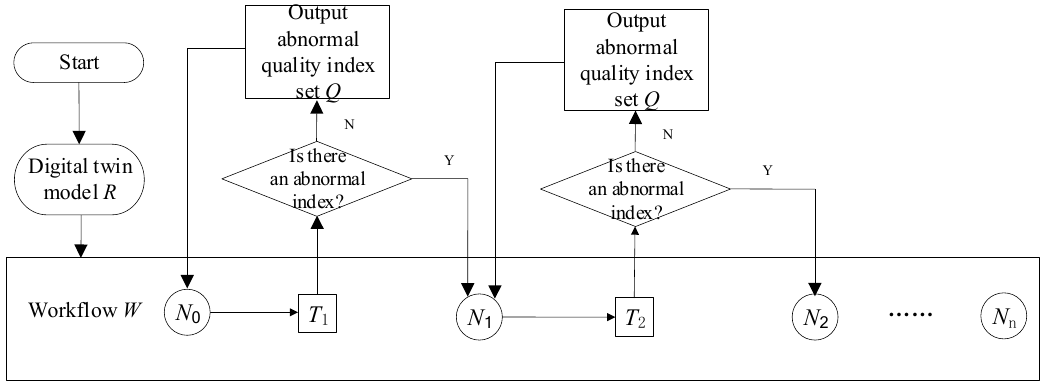
Figure 4. Macro-level model quality control process.